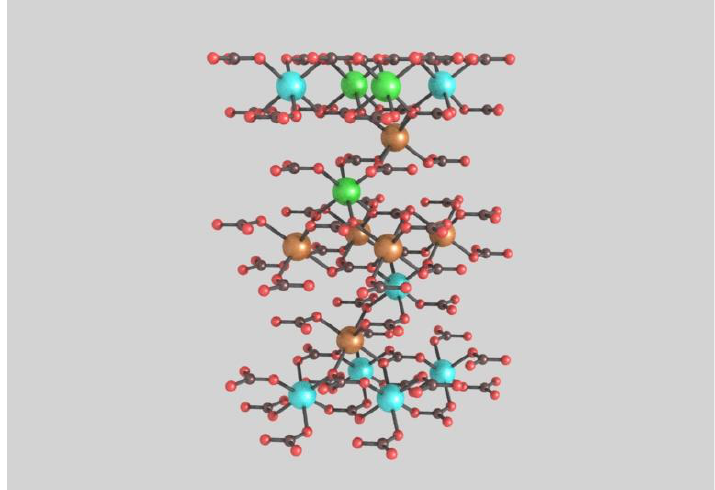
Figure 12. Diagram of Pb occupying the Ca or M position to form the octahedral ligand PbCO 3 : the brown ball is Mg; the green ball is Pb; the cyan ball is Ca; the black ball is C; the red ball is O.